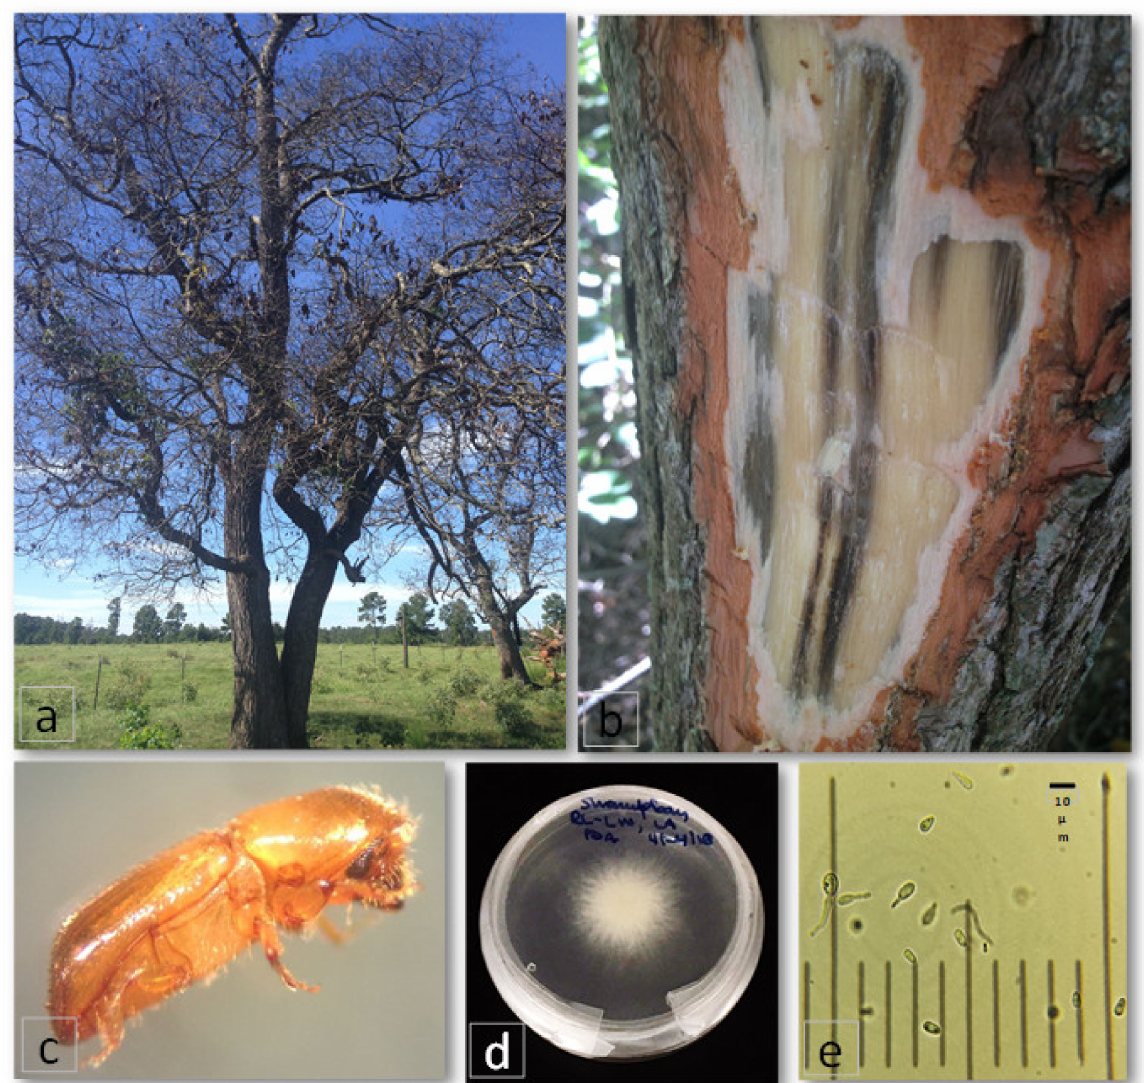
Figure 3. ( a ) An infected sassafras tree showing dead branches with symptoms of laurel wilt; ( b ) black streaks of xylem discoloration typical of laurel wilt on the infected tree; ( c ) a female redbay ambrosia beetle Xyleborus glabratus extracted from the bark of an infested sassafras tree; ( d ) an isolate of Raffaelea lauricola from an infected swampbay tree; and ( e ) microscopic oblong and ovoid conidia of R. lauricola observed under the